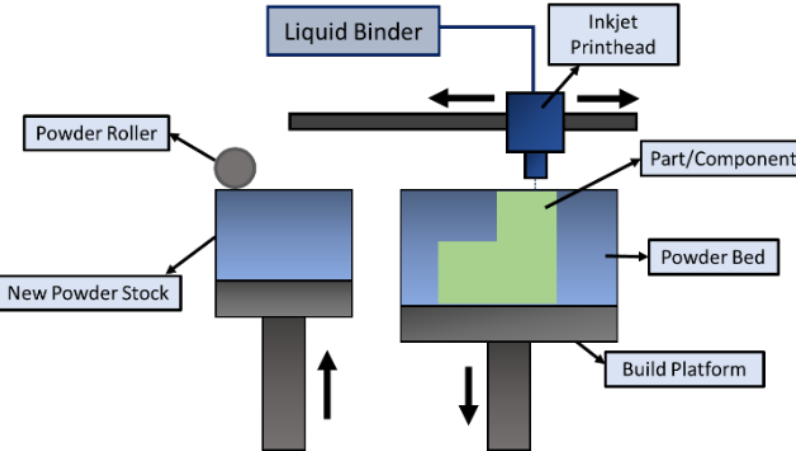
Figure 10. Schematic diagram illustrating the binder jetting process.